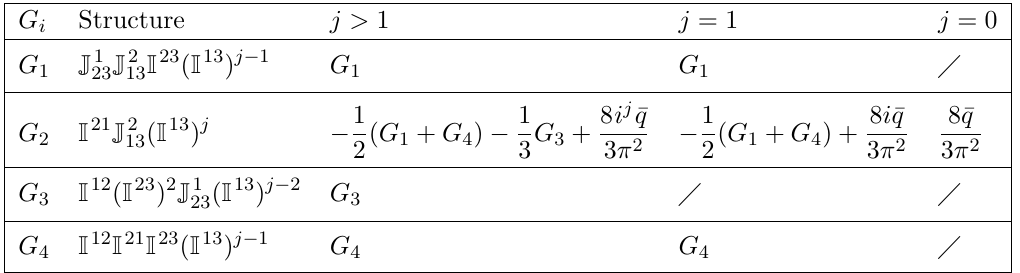
Table 7 . Ward identities of the supersymmetry current for the correlator spin ( 1 ; 1 j ). 2 2